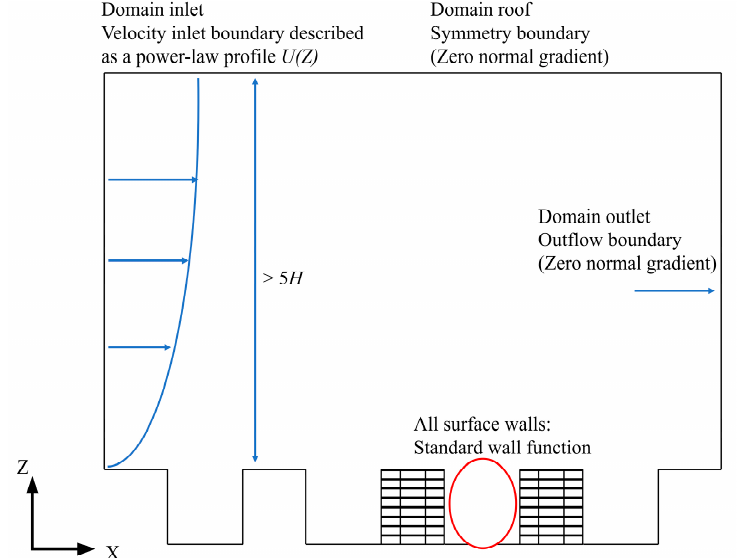
Figure 1. The computational domain and the boundary condition of the 2D street canyon model.